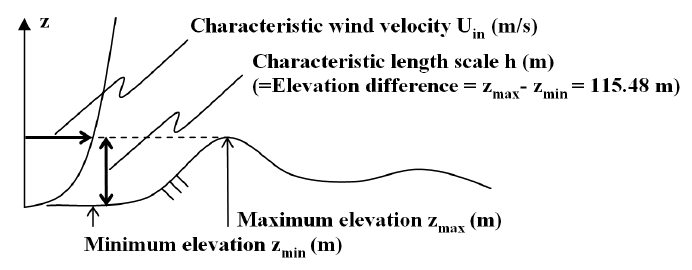
Figure 7. Characteristic two scales used in the present simulation.